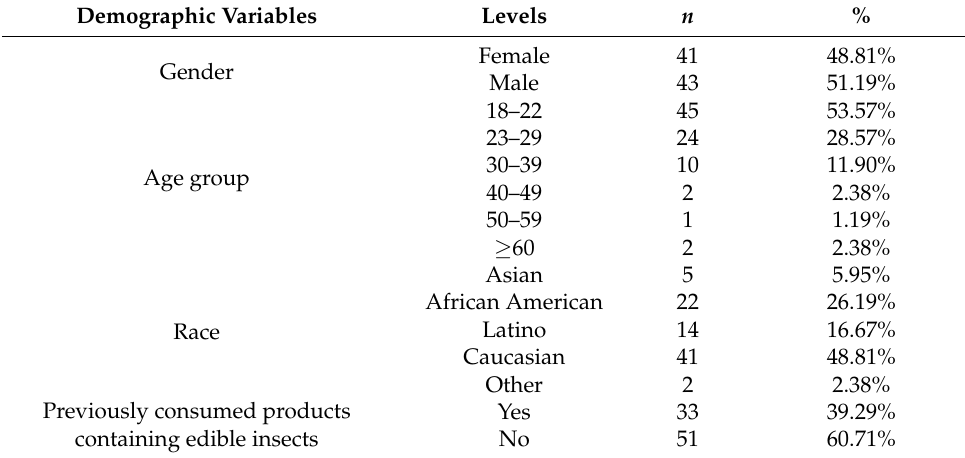
Table 2. Demographic profile of participants from the consumer